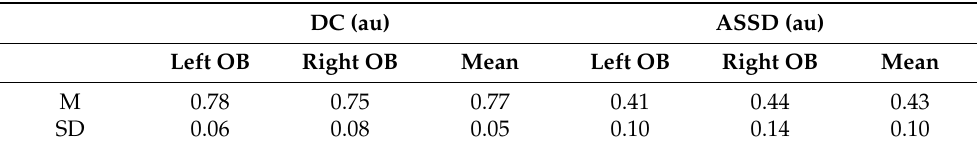
Table 3. Model performance metrics for the test dataset. DC (DC), Average Symmetric Surface Distance (ASSD). The unit (au) means arbitrary Figure 5. Automatic segmentation of the left (red) and right (green) OB in coronal T2 MRI scan performed manually by two independent raters and the algorithm.